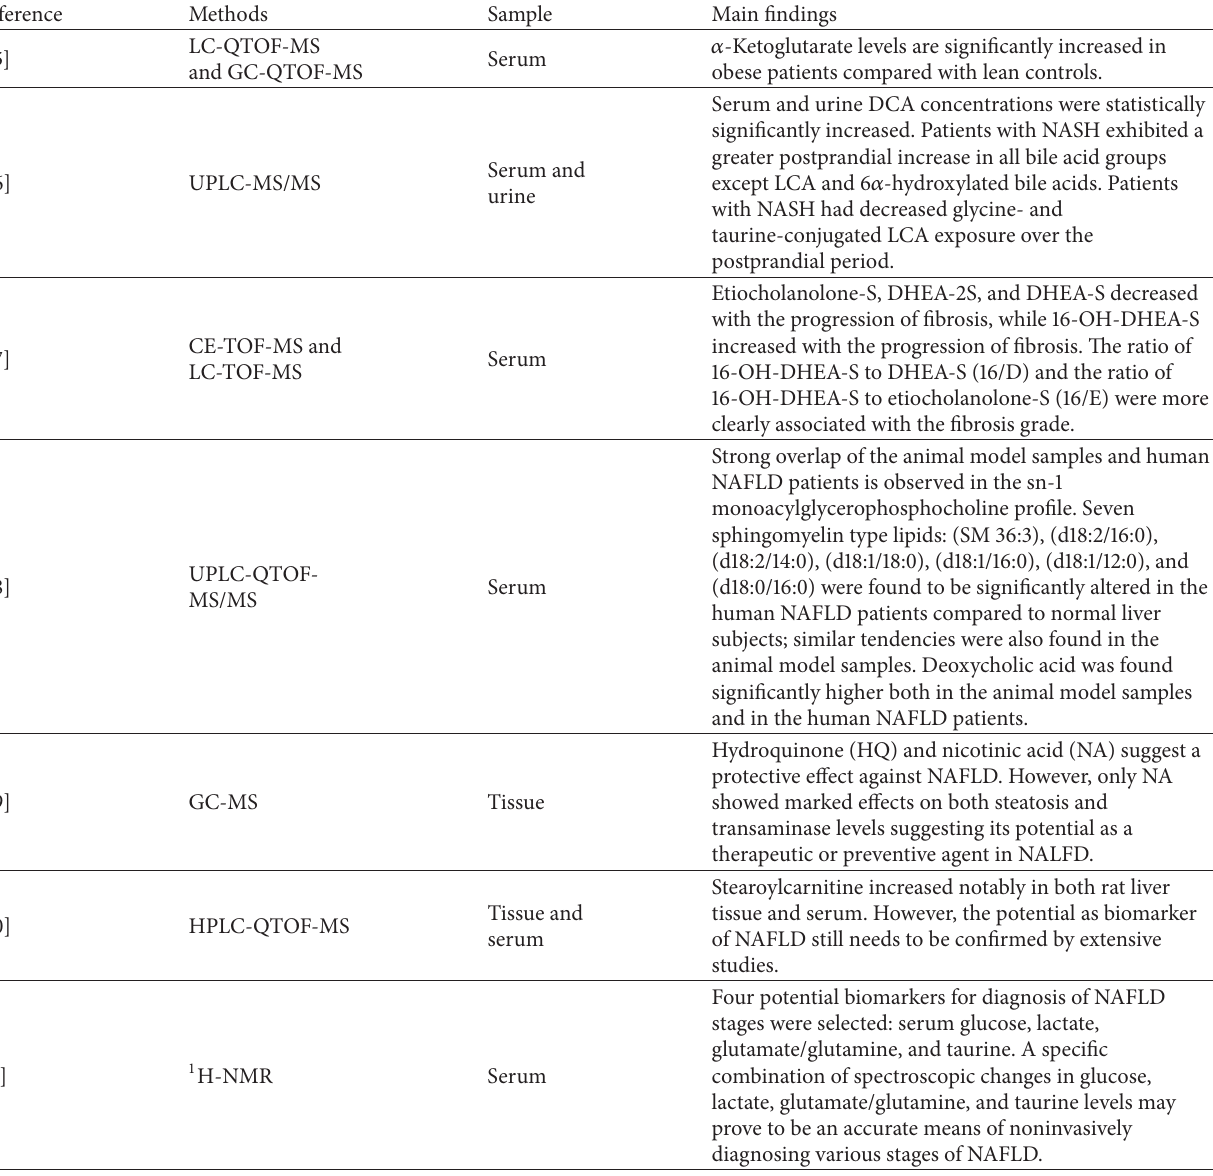
Table 3: The findings of metabolomic researches on